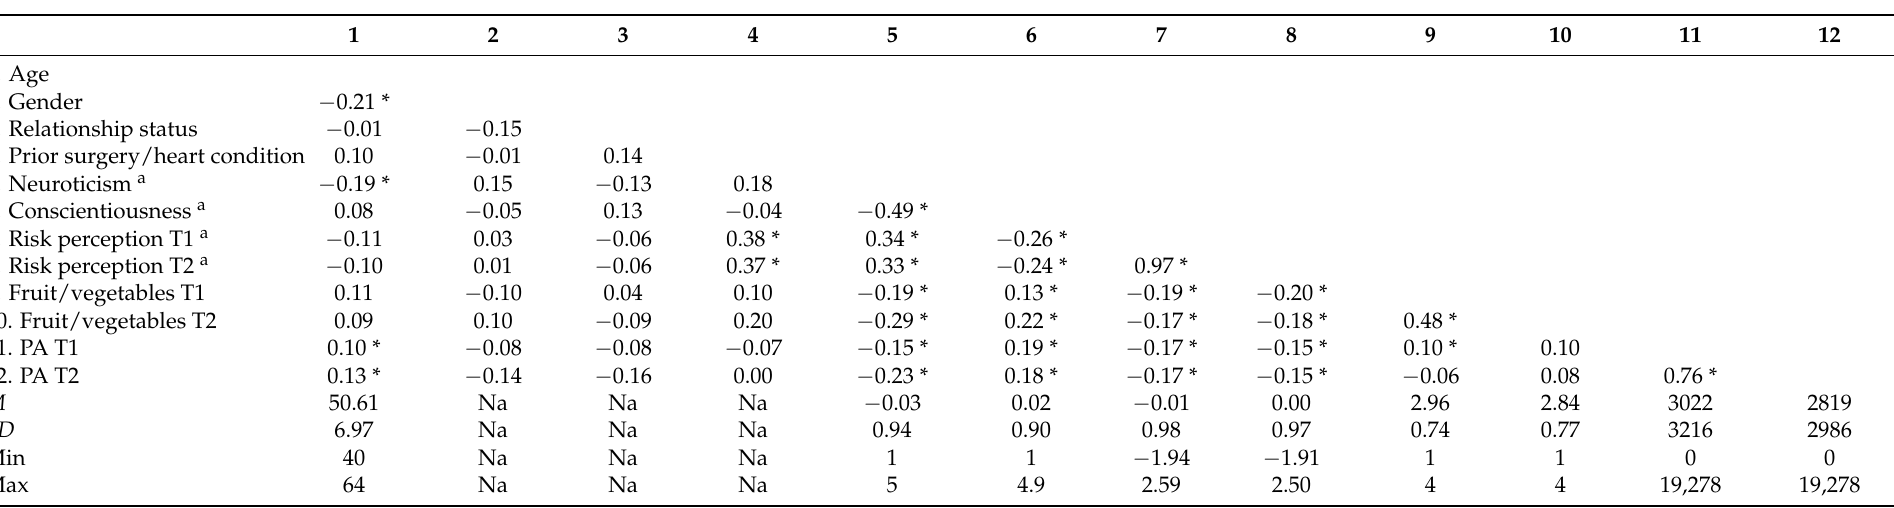
Table 2. Bivariate correlations among the study